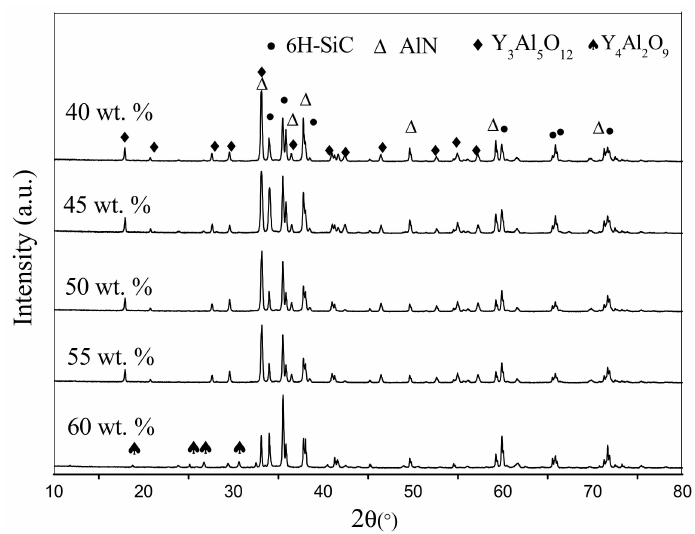
Figure 3. XRD patterns of SiC-AlN ceramics with different SiC contents.